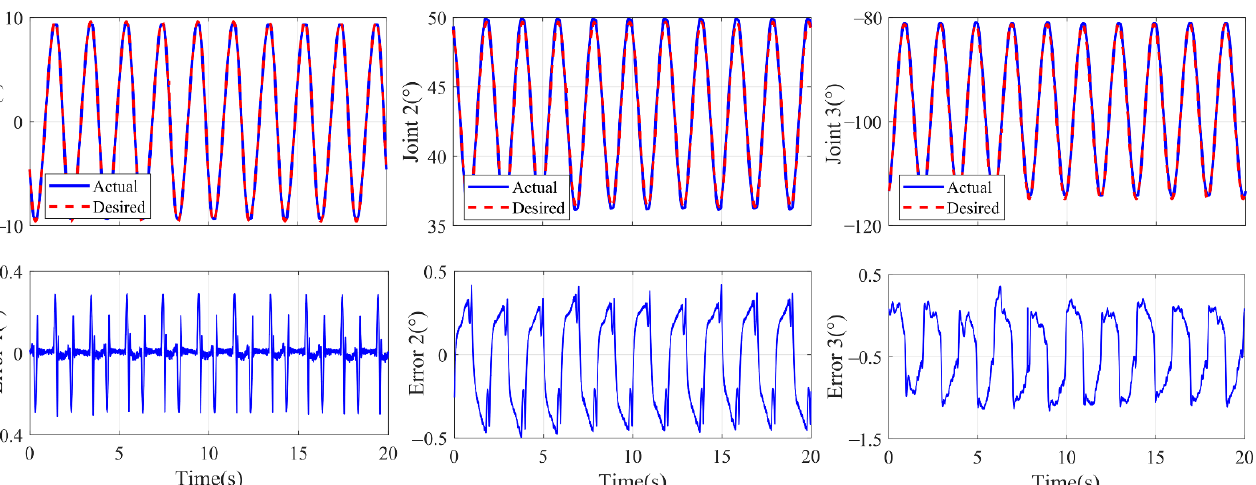
Figure 7. ( a ) Scene picture of a subject completing rehabilitation task ( b ) VR.